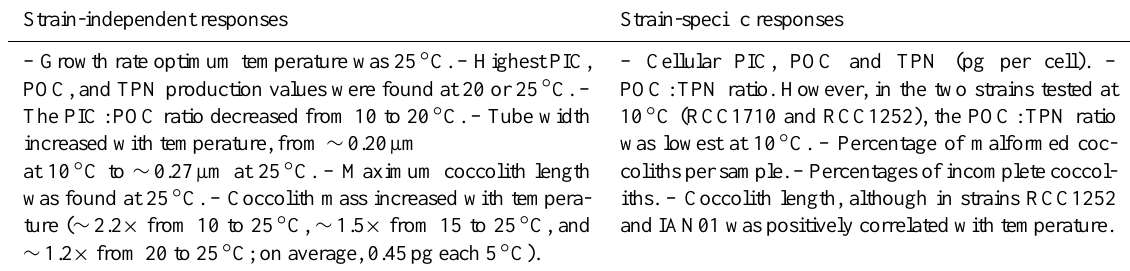
Table 5. Significant strain-independent and strain-specific responses of E. huxleyi to temperature found in the three strains of this study. Strain-independent responses Strain-specific responses